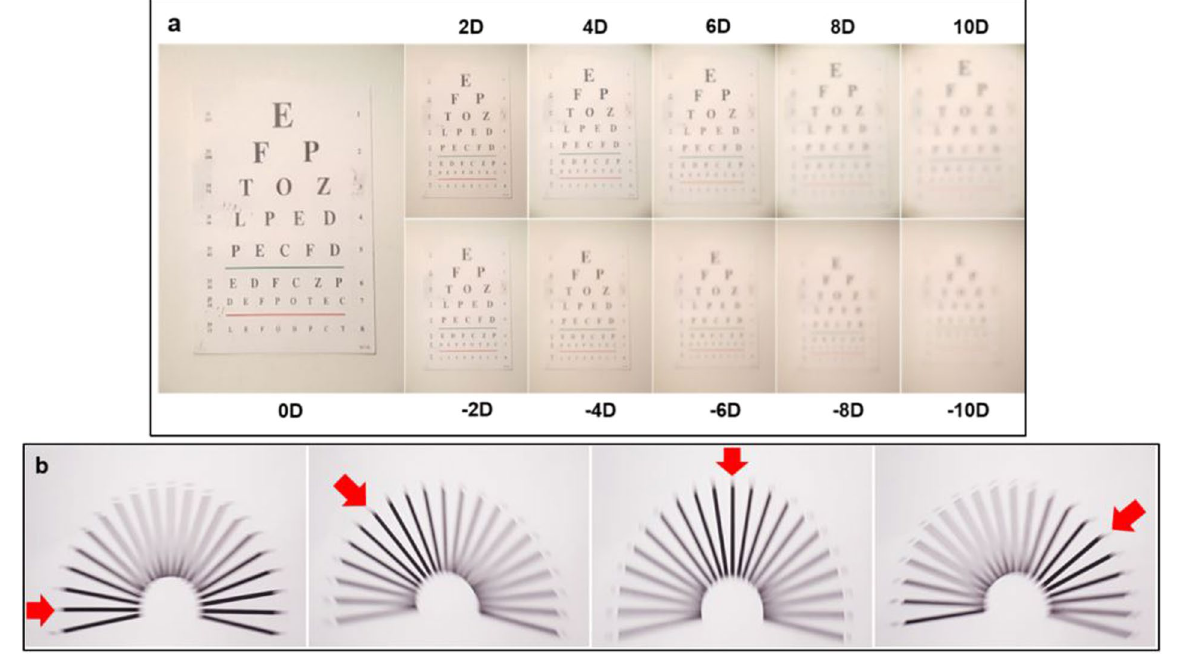
Figure 4. Test chart images captured through the fluidic lens setup. (a) The power of the defocus lens is changed from − 10 to + 10 diopters with two-diopter increments using the servo motor actuated pump. The increments can be as low as 0.1 diopters. (b) Astigmatism chart images. Three-diopter magnitude astigmatism is induced at 0°, 50°, 90°, and 140° using cylindrical lenses placed at 45 degrees with respect to each other. The angle can be controlled by changing the ratio between Z5 and